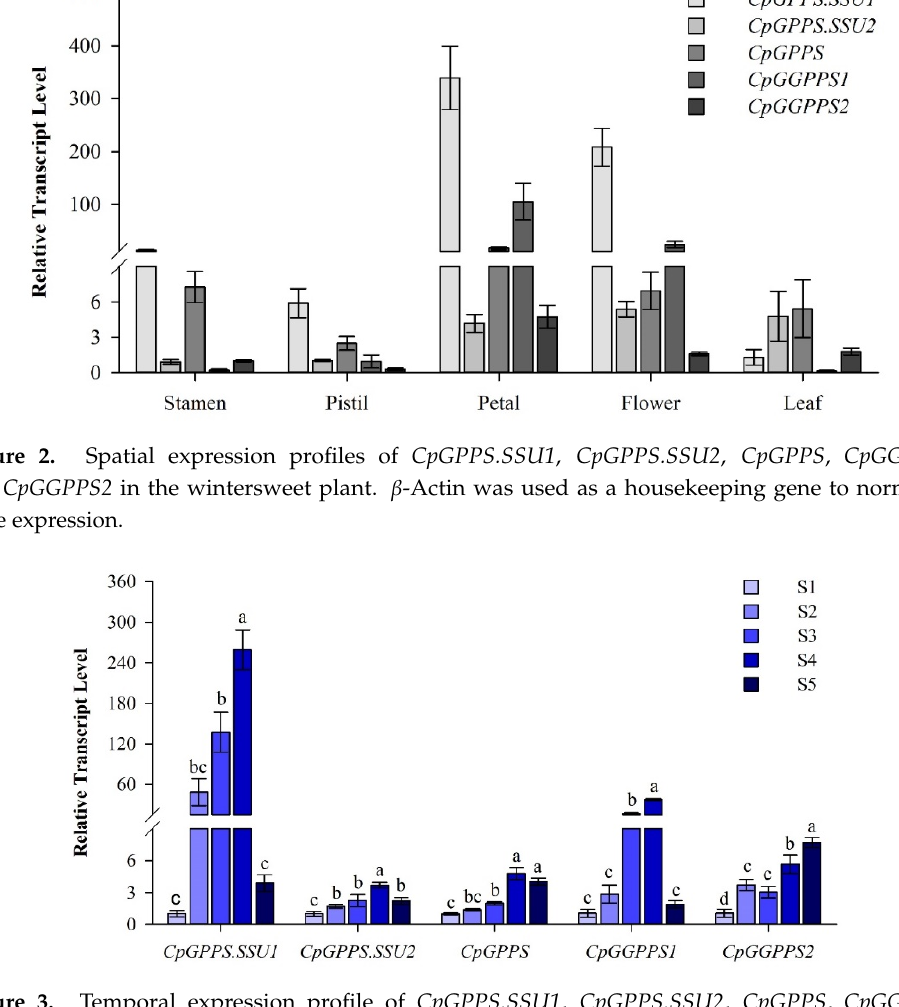
Figure 3. Temporal expression profile of CpGPPS.SSU1 , CpGPPS.SSU2 , CpGPPS , CpGGPPS1 , and CpGGPPS2 in di ff erent developmental stages of the wintersweet flower. Di ff erent lowercase letters on bars indicate significant di ff erences among tissues at p < 0.05 based on HSD post-hoc test. S1: Closed bud with green petals, S2: Closed bud with yellow petals, S3: Partial open flower, S4: Open flower but not pollinated, S5: Senescent flower.